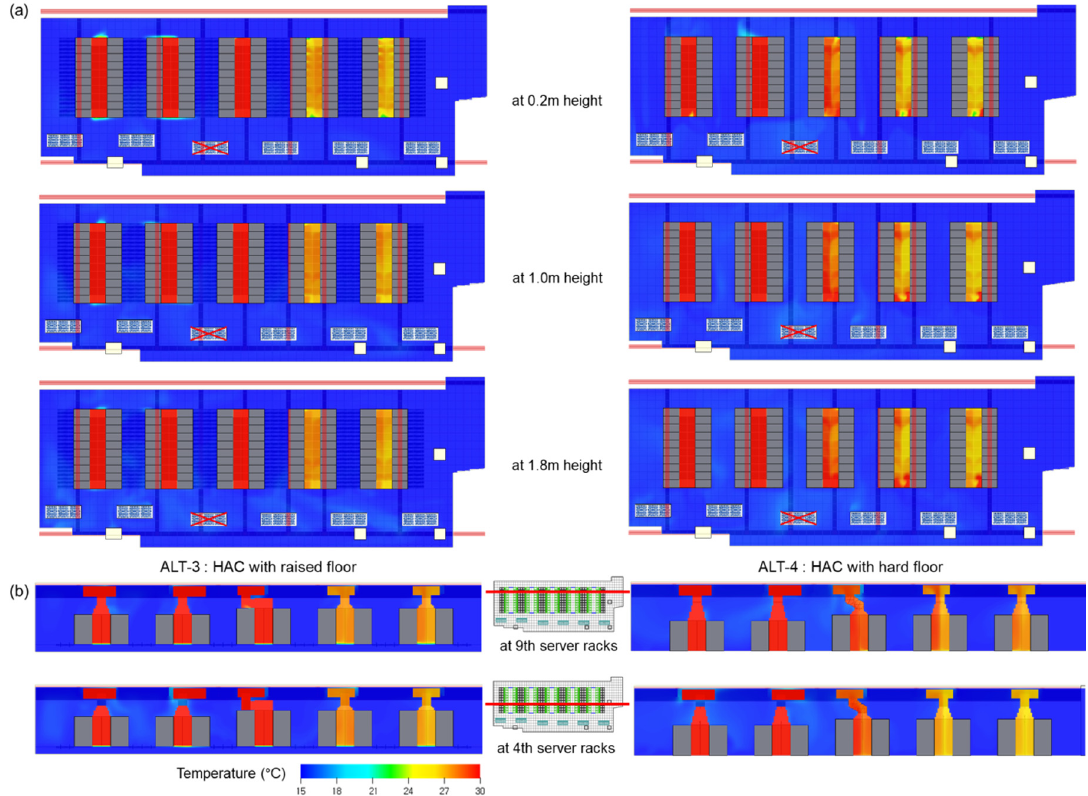
Figure 12. Contours of temperature under cooling fault condition; ( a ) a horizontal section view and ( b ) a vertical section view.